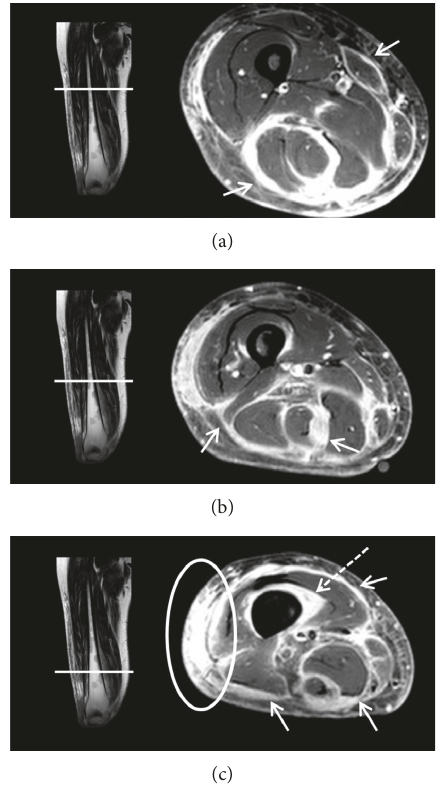
Figure 1: Coronal STIR and axial T1-weighted postcontrast SPIR magnetic resonance images of the upper (a), middle (b), and lower (c) right thigh. The images show considerable and diffuse inflammatory changes along the fasciae of all muscles of the right lower thigh (arrows) and surrounding the cortical bone of the distal femur (dotted arrow), and severe inflammatory changes surrounding the vessels of the popliteal fossa and subcutaneously at the knee level extending cranially along the lateral side of the thigh (circle).